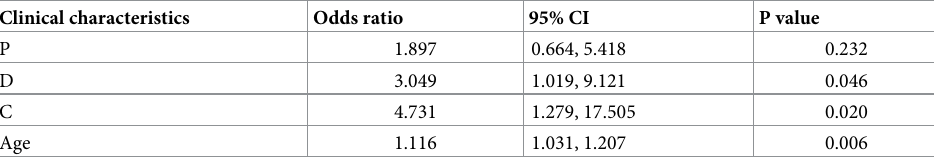
Table 3. Association between the signs of preclinical pseudoexfoliation and true exfoliation syndromes. Clinical